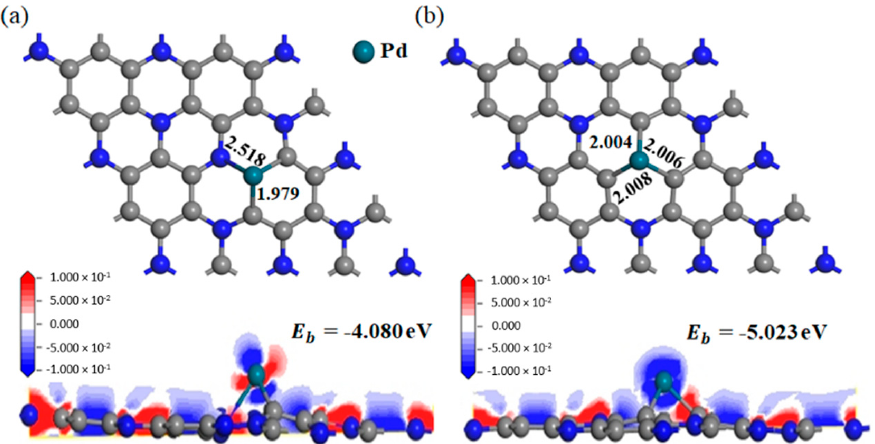
Figure 2. Top view of the optimized structure, side view of DCD ( a ) Pd doped in VC-C 3 N, ( b ) Pd doped in VN-C 3 N.